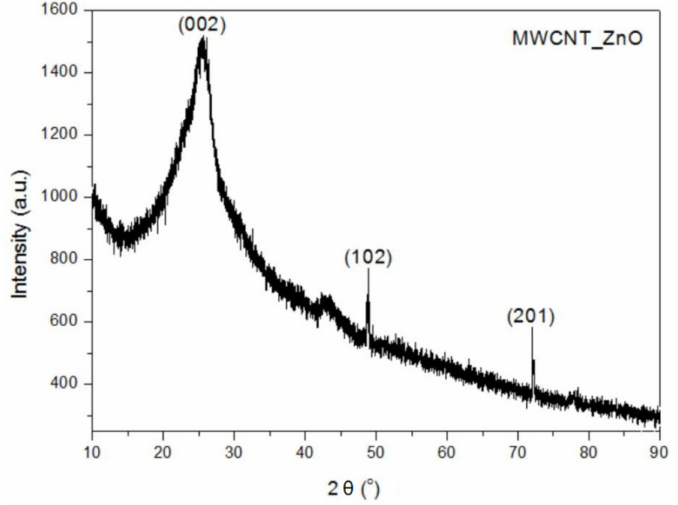
Figure 4. XRD of